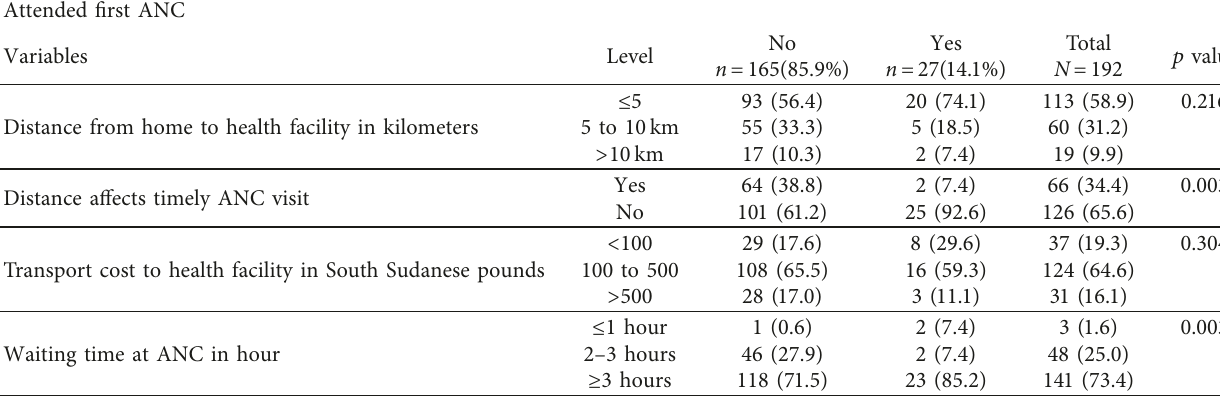
Table 4: Bivariate analysis of health facility factors and timely attendance of the first ANC. Attended first ANC Variables